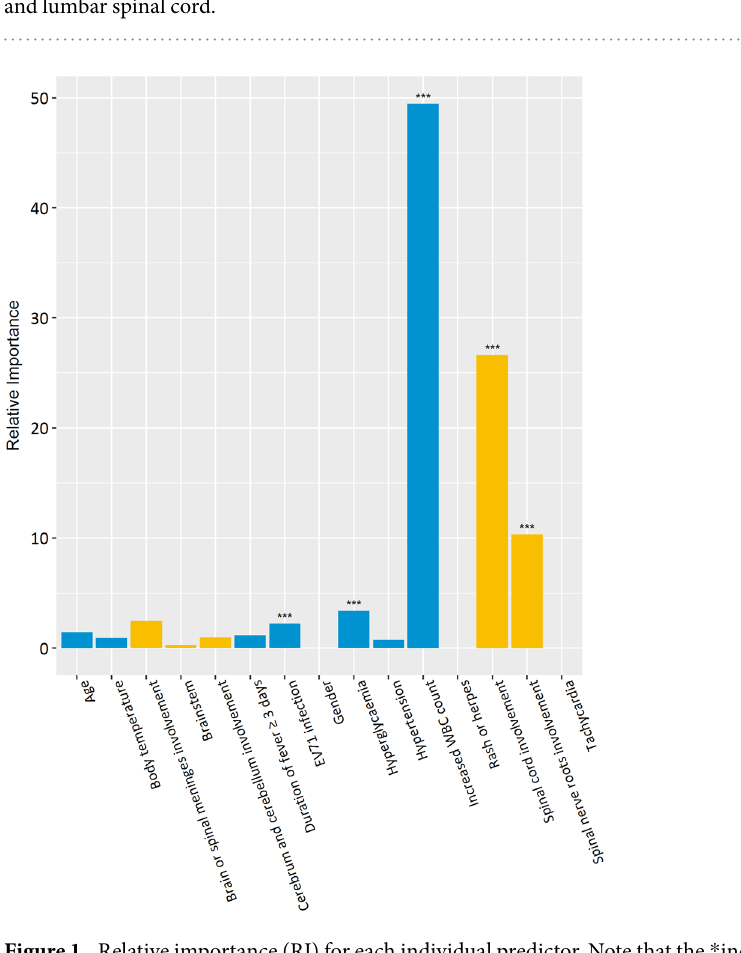
Figure 1. Relative importance (RI) for each individual predictor. Note that the * indicated the level of significance, p-value < 0.001. MRI-related predictors were in yellow and clinical predictors were in